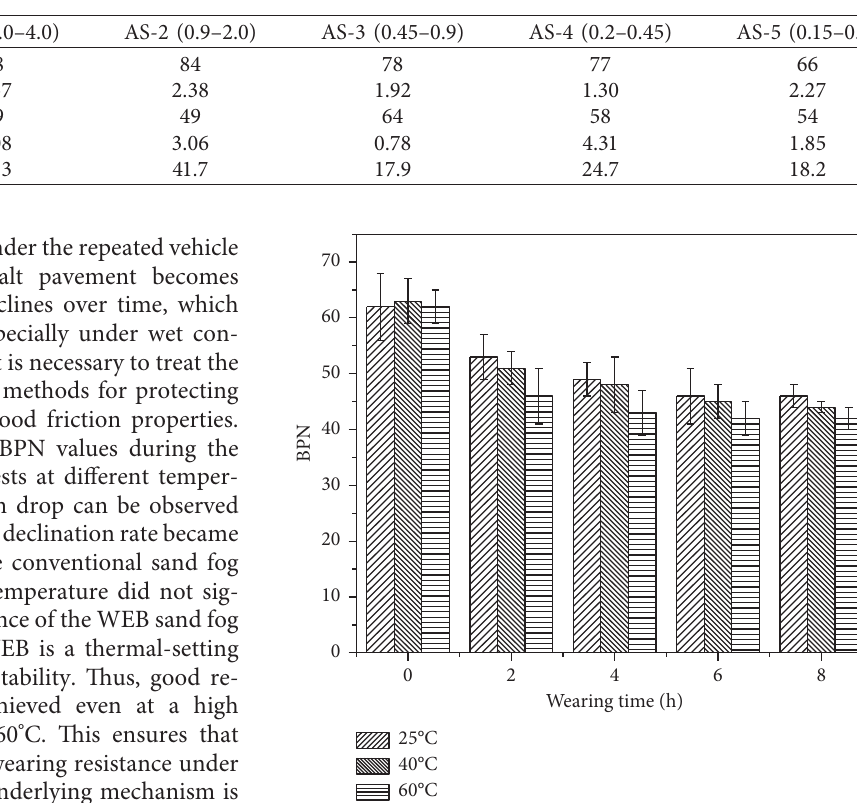
Table 5: Skid resistance test results before and after abrasion.